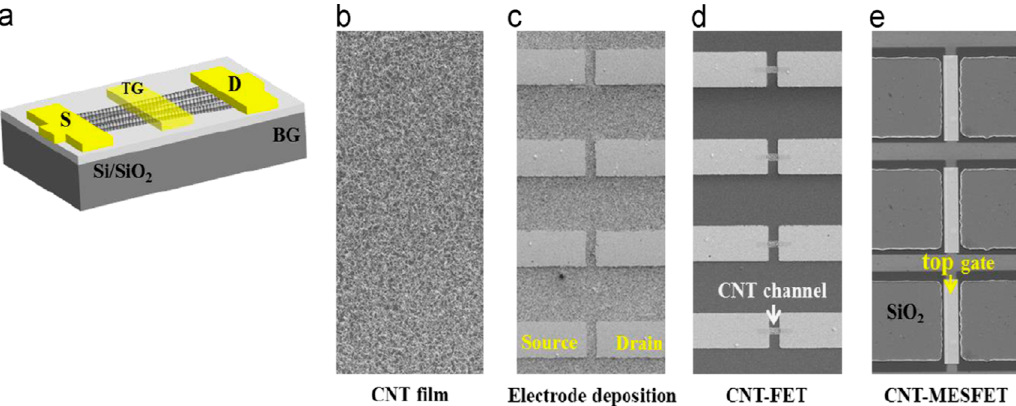
Figure 3. ( a ) Schematic diagram of a carbon nanotubes (CNTs)-metal semiconductor field effect transistor structure device. ( b – e ) Fabrication procedure of the metal semiconductor field effect transistor structure device (Reproduced with permission from [44]. Elsevier, 2013).